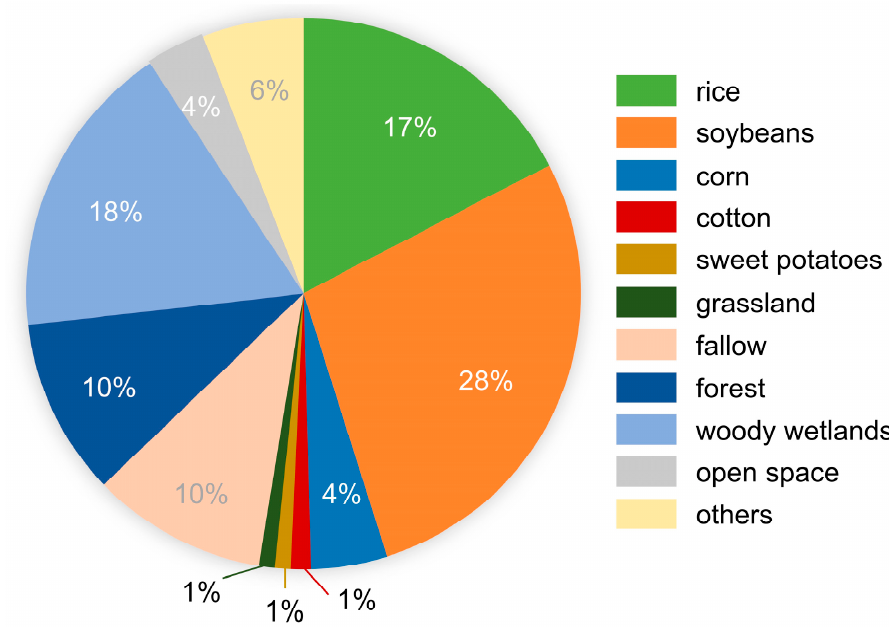
forest and woody wetland, which are accounted for a large proportion of the test data, are